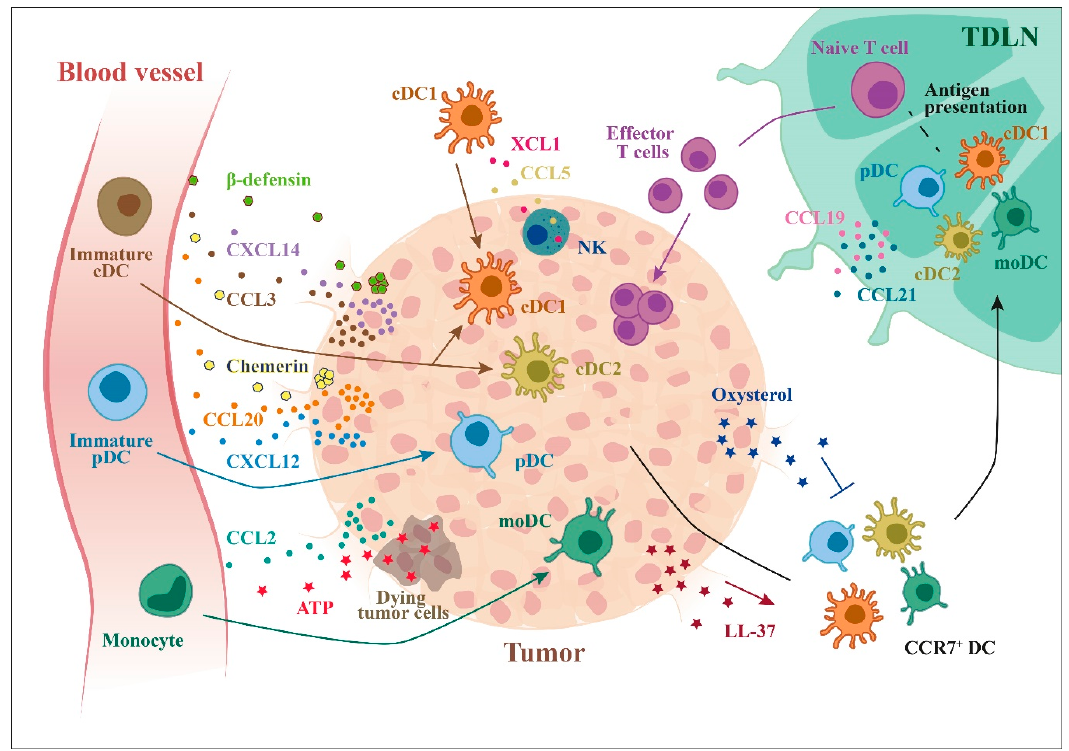
Figure 3. Recruitment of DCs to tumor microenvironment. Tumor cells can secrete many factors that can recruit different DC subsets: chemokines, such as CCL20, CXCL12, and CXCL14, and other molecules, such as ATP (from dying cells) or β -defensins. Tumor cells can also produce factors that inhibit the recruitment of CCR7 + DCs to lymph nodes (e.g., oxysterols). Tumor infiltrating cDCs derive from a bone marrow precursor (pre-cDC) that migrate from blood to tumor to differentiate in proliferating cDCs. In different transplantable tumor models, this process was shown to be largely driven by the tumor expression of CCL3, a ligand of CCR1 and CCR5, two chemokine receptors expressed by pre-cDCs [120]. However, tumor moDCs may also